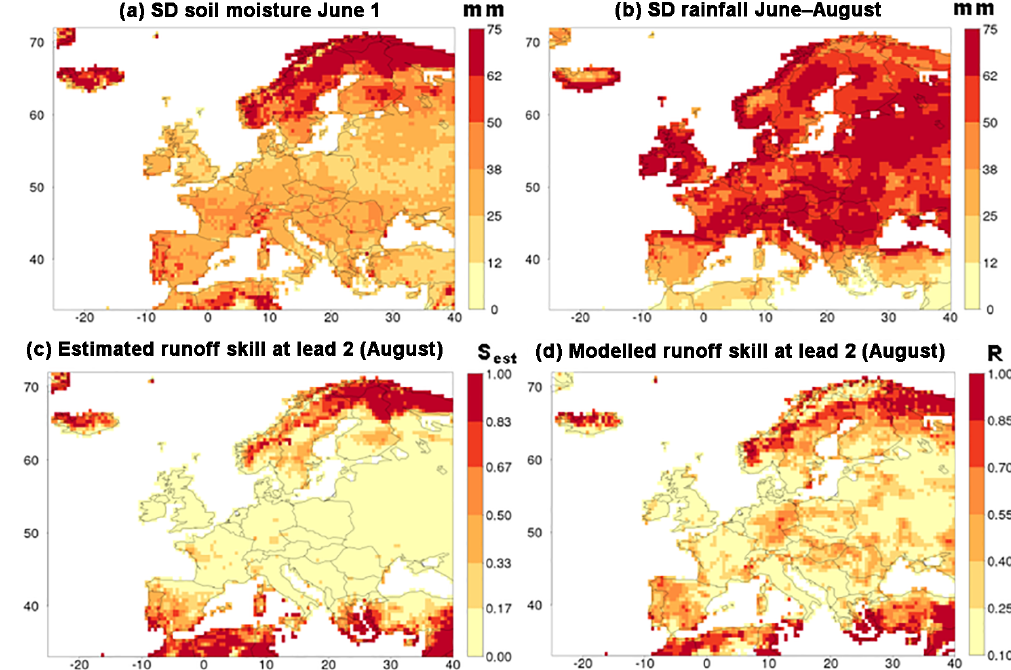
Figure 12. Illustration of a simple method that partly explains skill in run-off due to initial soil moisture, exemplified for target month August as lead month 2. (a) is a map of the standard deviation in soil moisture at the date of initialisation (1 June). Similarly, (b) maps the standard deviation of observed rainfall during the course of the hindcasts (June–August). These two standard deviations are combined into an estimate of the skill (Eq. 1) in (c) , which is compared with the skill of the FullSHs (d) . Note that the colour scales of (c) and (d) differ from each other and differ from scales of other figures (e.g. Fig.